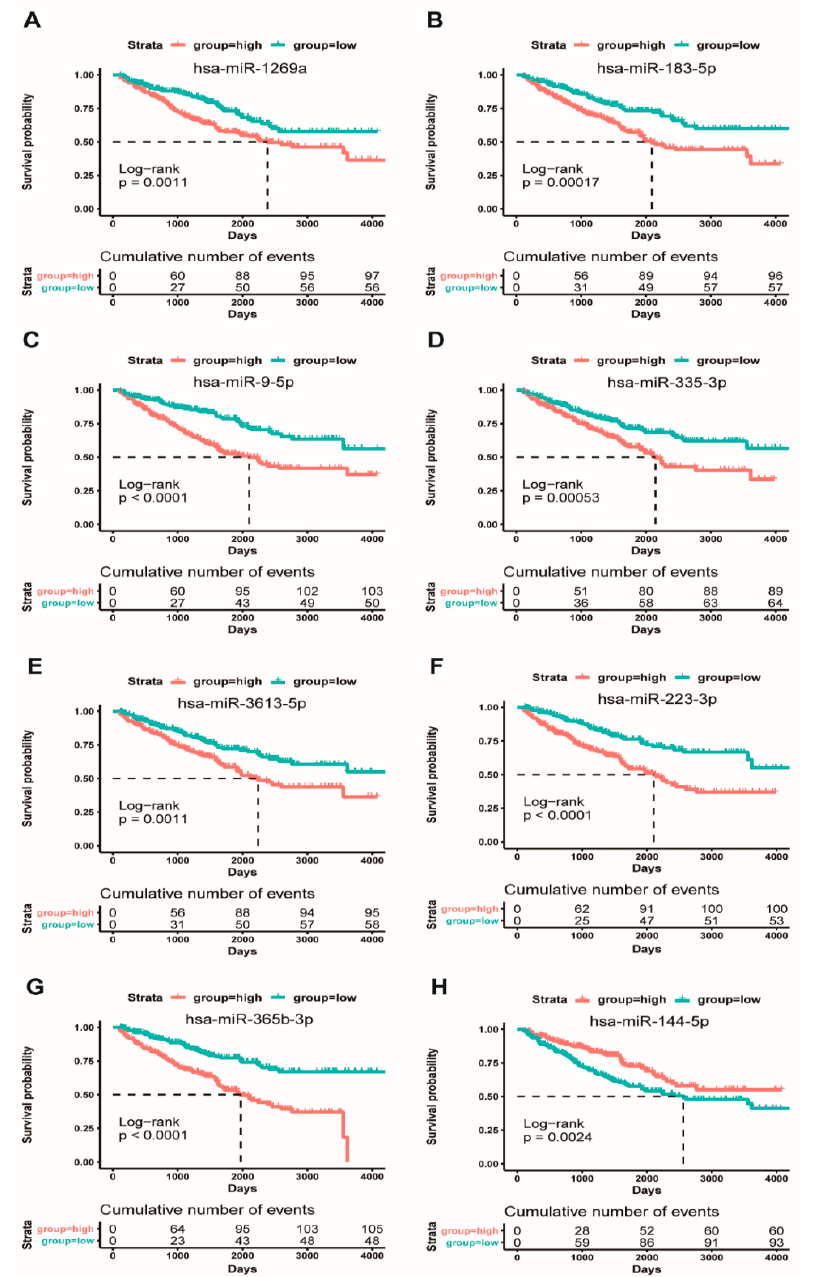
Figure 2. Kaplan Meier survival based on the expression level of eight miRNAs. Overall survival curves for high-expression and low-expression ccRCC patient cohorts. ( A ): hsa-miR-1269a; ( B ): hsa-miR-183-5p; ( C ): hsa-miR-9-5p; ( D ): hsa-miR-335-3p; ( E ): hsa-miR-3613-5p; ( F ): hsa-miR-223-3p; ( G ): hsa-miR-365b-3p; and, ( H ): hsa-miR-144-5p.